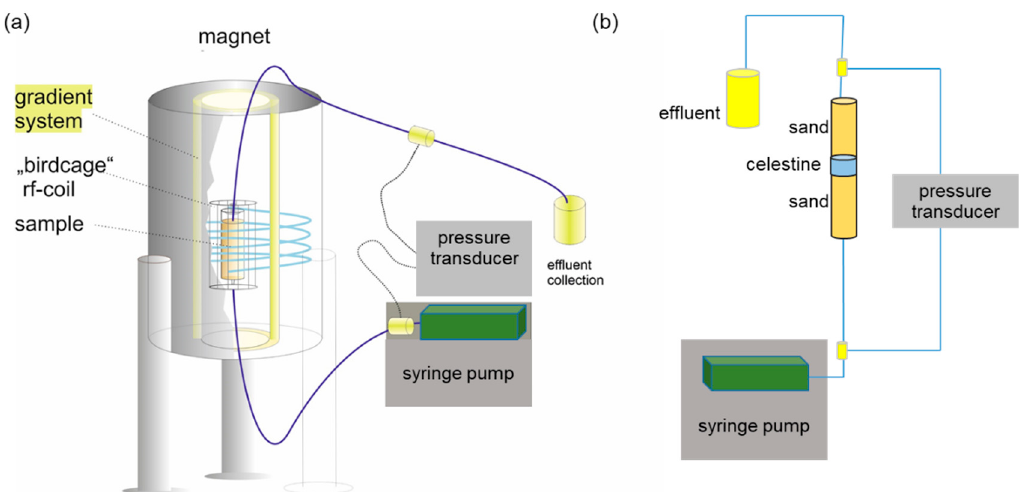
Figure 1. ( a ) Schematic representation of the experimental setup with the flow through column placed in a high field magnetic resonance imaging scanner. It is composed of a superconducting magnet, a gradient system for creating magnetic field gradients for imaging in three Cartesian directions, and a radiofrequency coil (200 MHz) for the excitation and detection of the NMR signal. The sample is inserted into the rf -coil, whereas the other components of the setup such as pressure transducer and pump are placed outside to avoid disturbance by the magnet’s stray field. ( b ) experimental setup for permeability measurements.